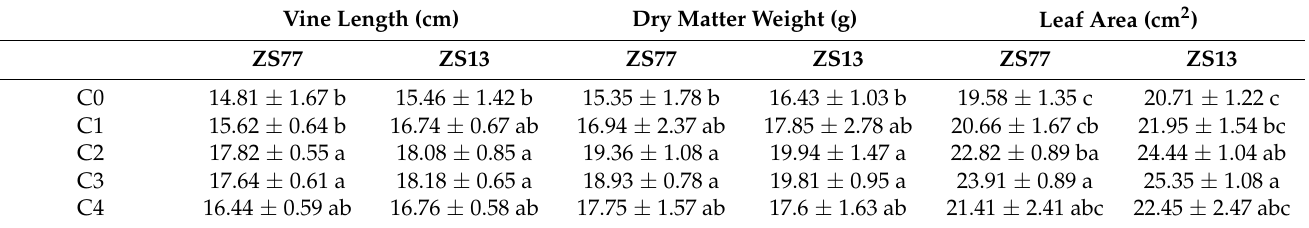
Table 4. Effects of exogenous SA on growth traits of sweet potato under drought stress. Vine Length (cm) Dry Matter Weight (g) Leaf Area (cm 2 ) ZS77